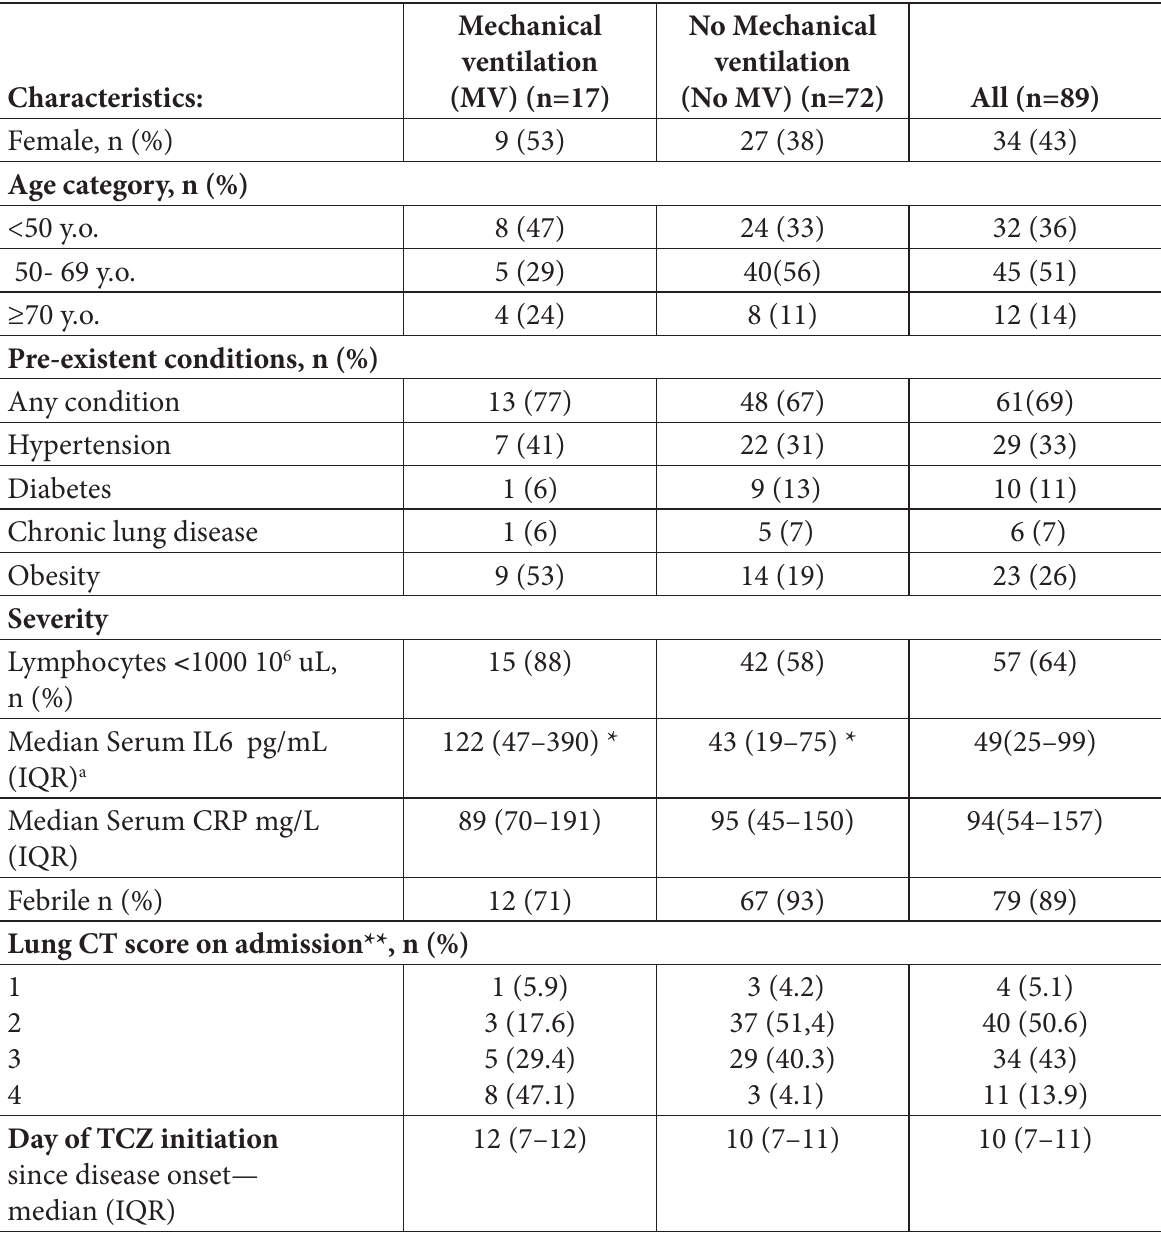
Table 1. Clinical characteristics of patients before administration of Tocilizumab Mechanical Characteristics: (No MV) (n=72) All (n=89) Female, n (%) 9 (53) 27 (38) 34 (43) Age category, n (%) <50 y.o. 8 (47) 24 (33) 32 (36) 50- 69 y.o. 5 (29) ≥70